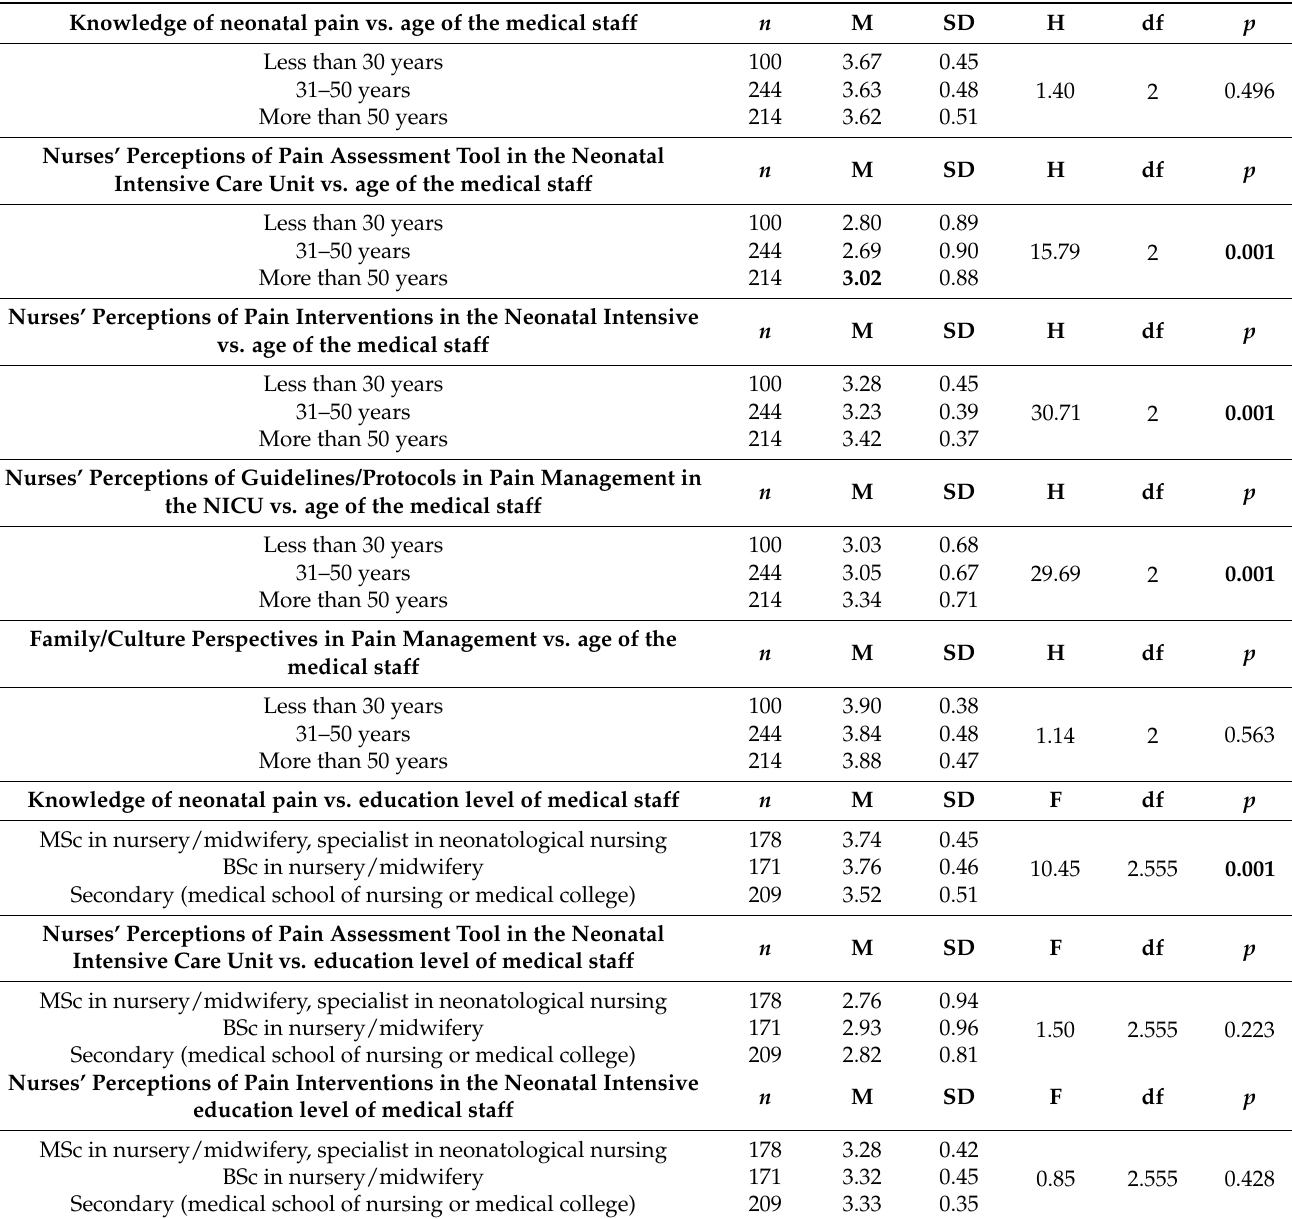
Table 3. A detailed correlation analysis for variables: knowledge and beliefs about neonatal pain, nurses’ perceptions of pain assessment tool in the neonatal intensive care unit, nurses’ perceptions of pain interventions in the neonatal intensive, nurses’ perceptions of guidelines/protocols in pain management in the NICU, family/culture perspectives in pain management. Knowledge of neonatal pain vs. age of the medical